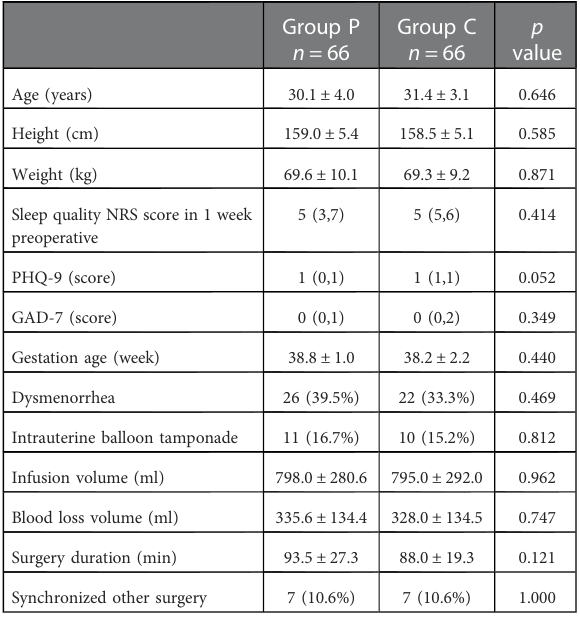
TABLE 1 Demographic, preoperative, and intraoperative